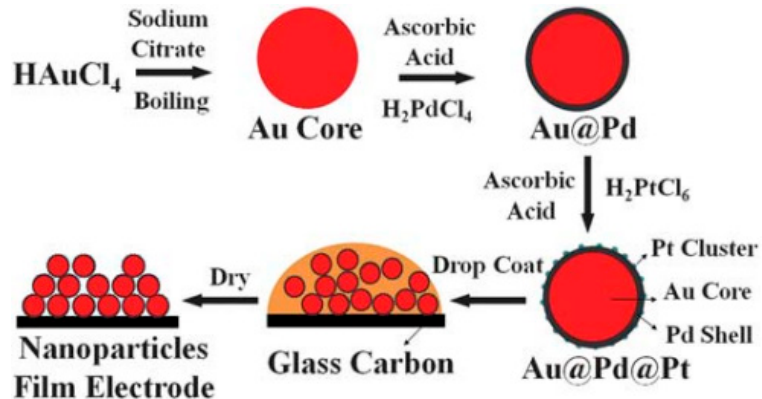
Figure 4. The procedure used to prepare an Au@Pd@Pt NP film on a glass carbon (GC) electrode. Reproduced with permission from reference